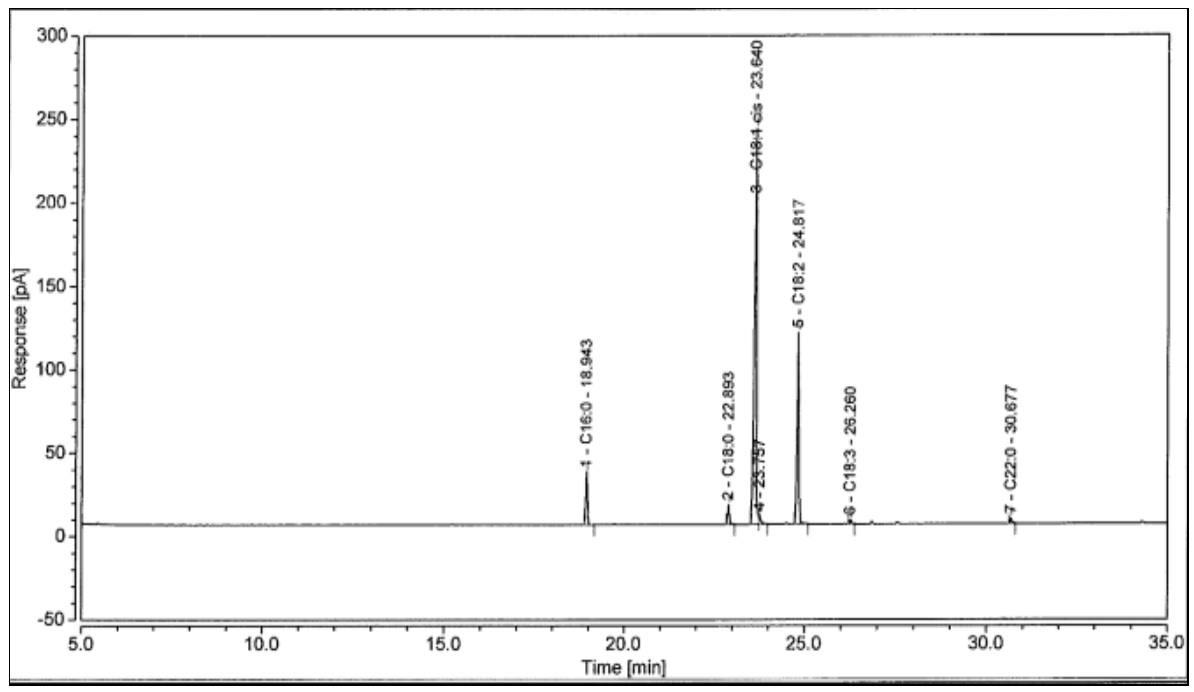
Figure 3. GC profile of SFO biodiesel.